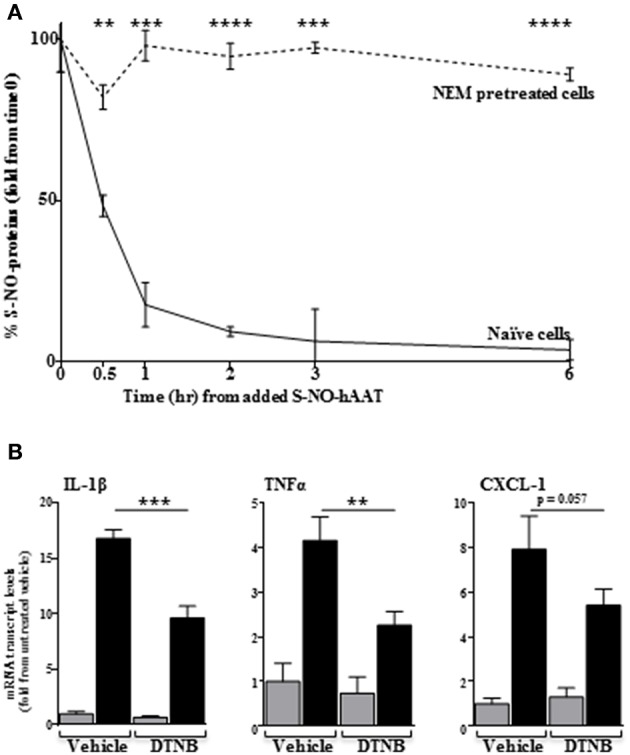
Transnitrosylation-dependent activity of S-NO-hAAT. (A) Amount of remaining nitrosylated proteins in supernatant following S-NO-hAAT introduction to naïve (solid) and NEM-pretreated (dashed) peritoneal macrophages (1 × 106 per well, n = 3). (B) DTNB or DMSO (vehicle)-pretreated peritoneal macrophages (0.25 × 106 per well, n = 3) were examined for mRNA levels without S-NO-hAAT (gray) or 1 h after introducing it (black). Data are presented as mean ± SD, **p < 0.01, ***p < 0.001, and ****p < 0.0001.